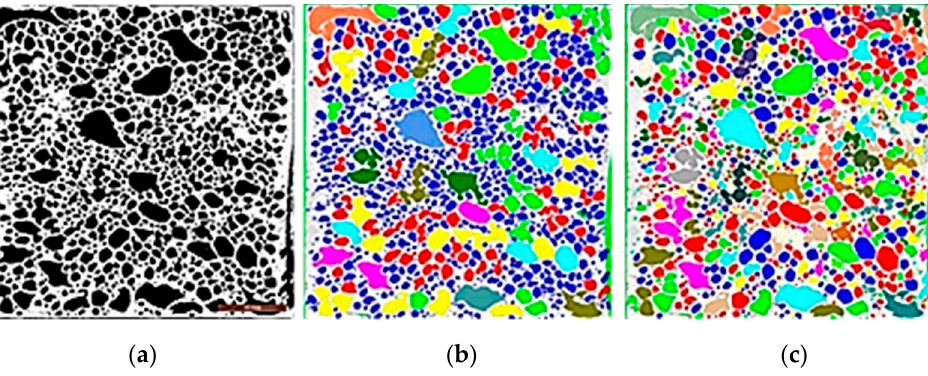
Figure 6. Segmentation of ( a ) a foam image to analyze ( b ) size and ( c ) roundness of cells.